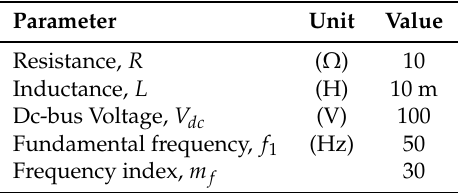
Table 1. Parameters for the experimental